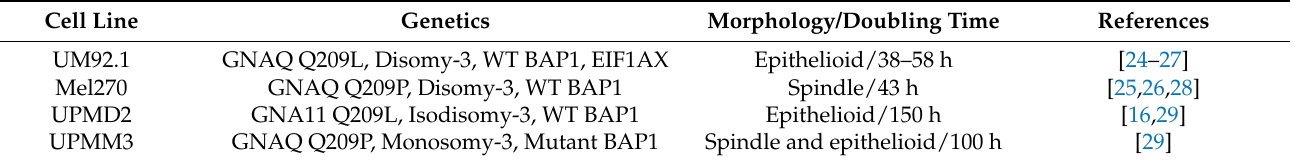
Table 1. Characteristics of uveal melanoma cell